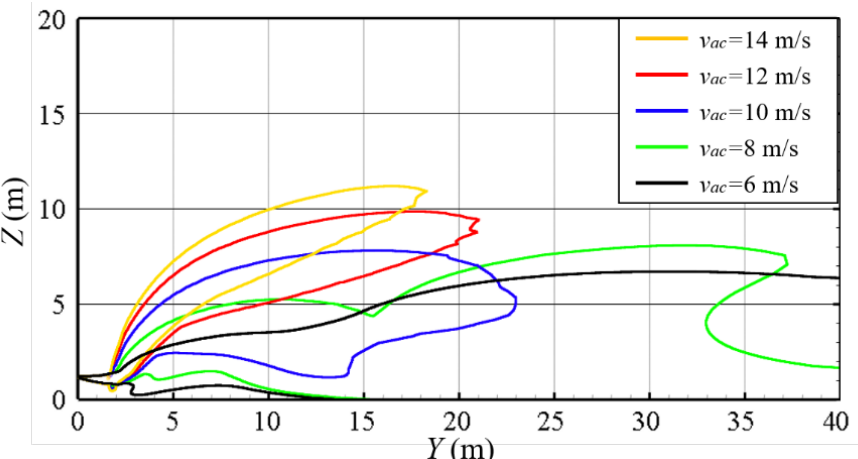
Figure 11. Iso-surface of 4% hydrogen concentration with various v ac values ( w ac = 0.25 m, d ac = 2 m, t = 100 s).